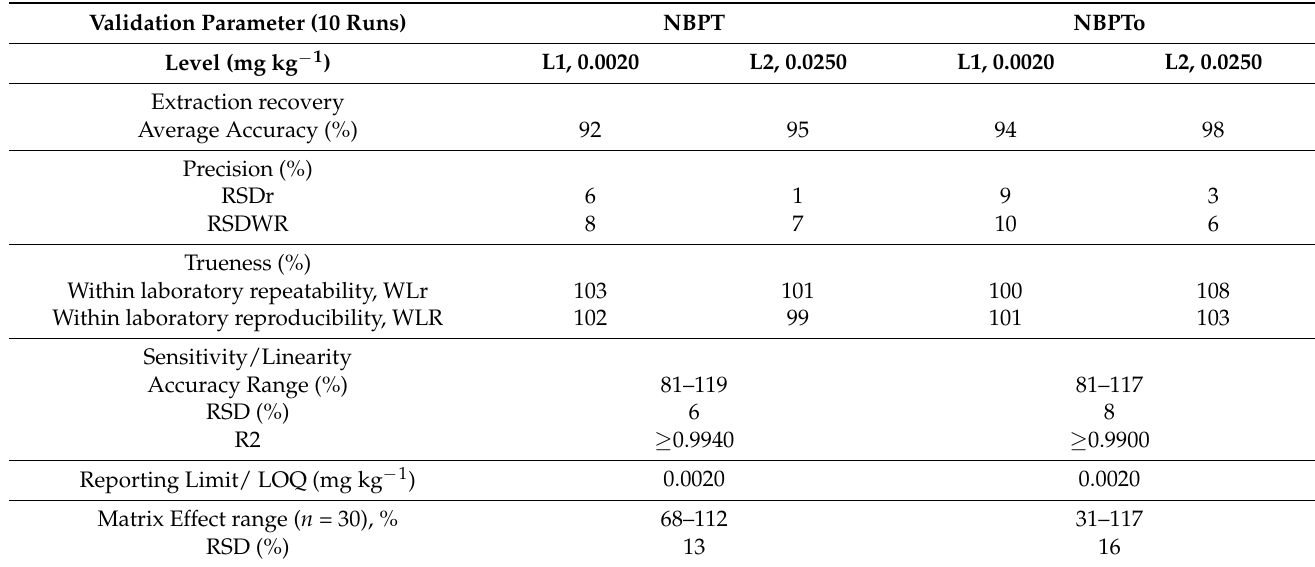
Table 1. Summary of validation